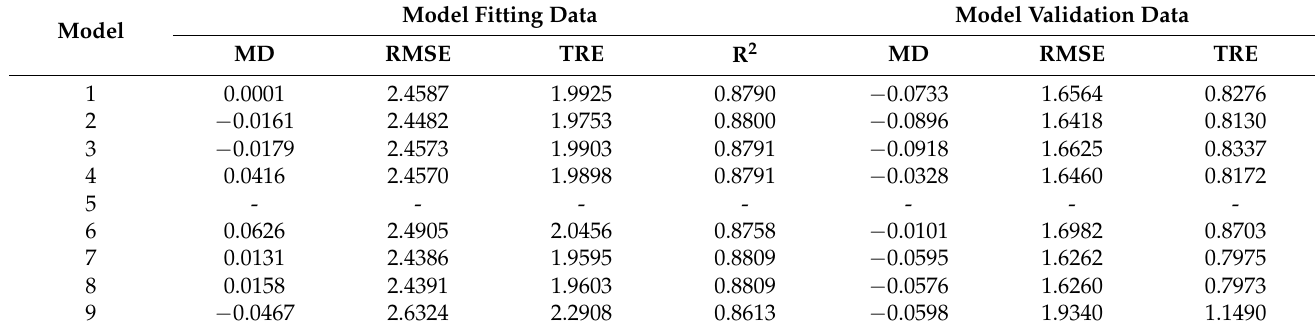
Table 5. Statistics of the converged base models for the model fitting and validation datasets (MD (mean prediction error), RMSE (root mean square error), TRE (total relative error), and R 2 (coefficient of